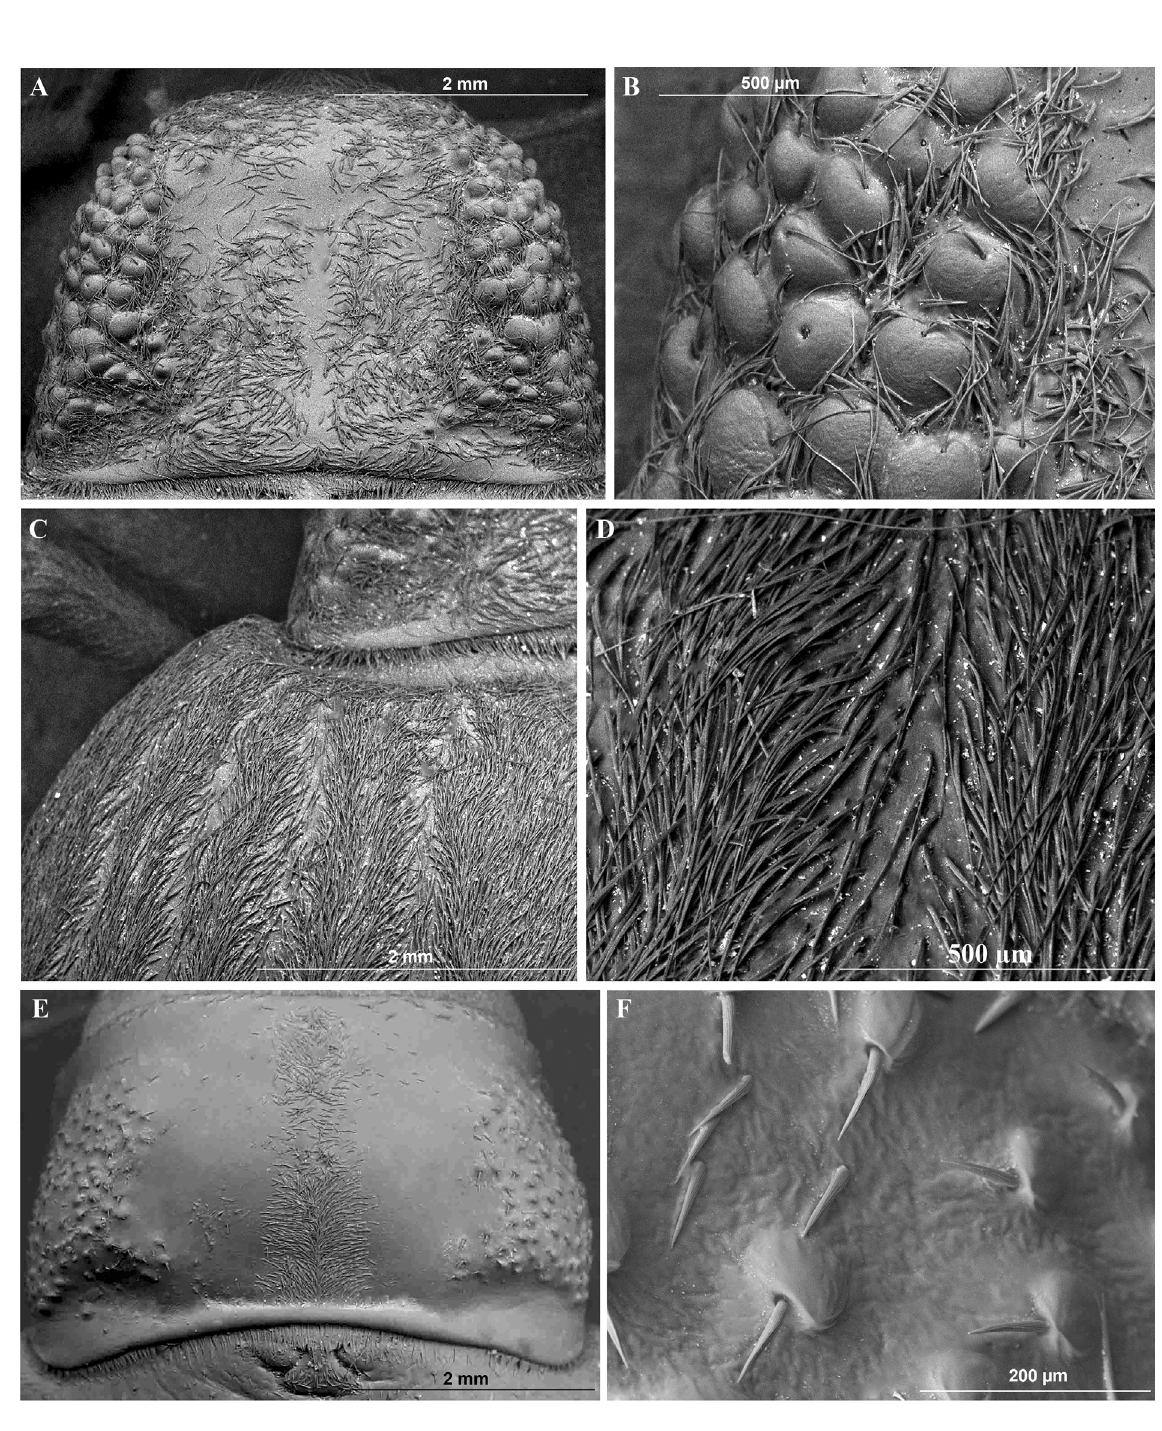
Fig. 11. Przewalskia Semenov, 1893 and Mantichorula Reitter, 1889, details of structure. A . P. dilatata (Reitter, 1887), ♂ (ZIN), pronotum. B . Ditto, hemispherical large tubercles on pronotum. C . Ditto, base of left elytron. D . Ditto, pubescence of elytron. E . M. semenowi Reitter, 1889, ♂ (ZIN), pronotum. F . Ditto, tubercles and setation on sides of